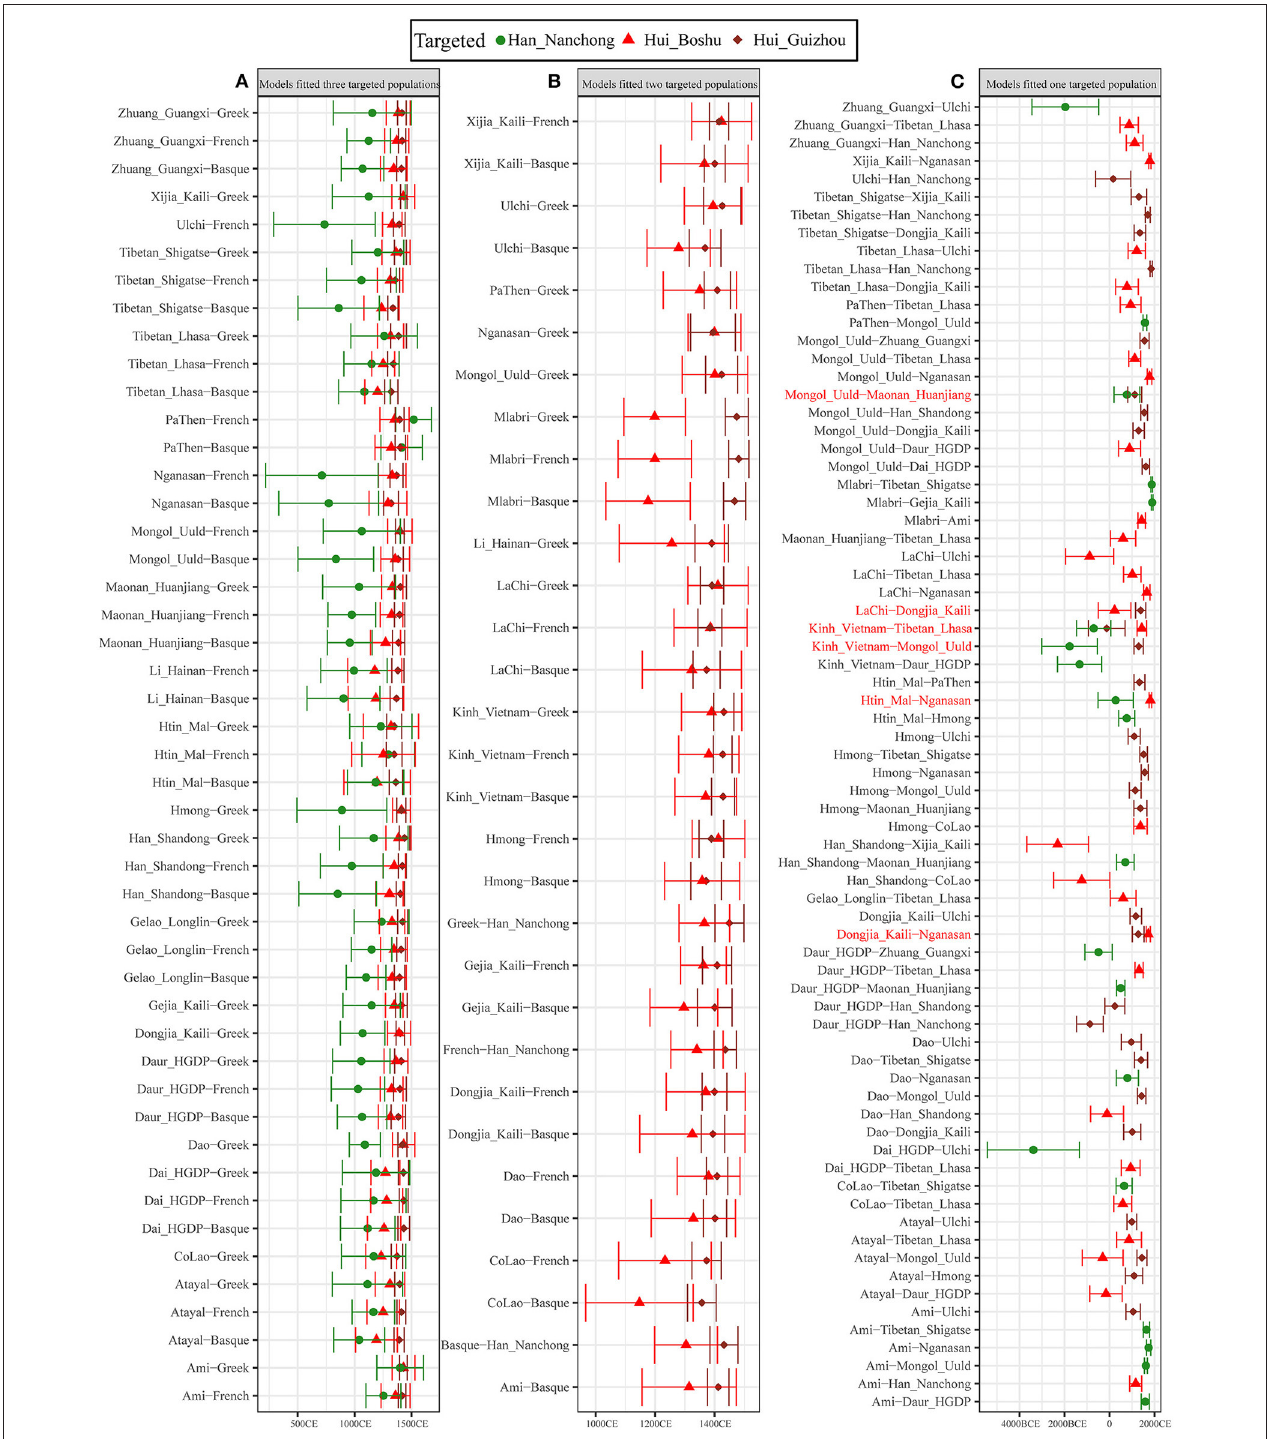
FIGURE 7 | Admixture-introduced linkage disequilibrium (ALDER)-based admixture time between different northern and southern or eastern and western ancestral sources based on the 1,240K dataset. (A) East–west ancestral source pairs fitted all three studied populations. (B) East–west ancestral source pairs fitted all two studied Hui populations but not fitted Nanchong Han. (C) East–west ancestral source pairs only fitted one studied population. One north–south ancestry source pair fitted three studied populations, and five north–south ancestry source pair fitted two studied populations also included in here; pairs were marked with the red color. We used 28 years as the one-generation length. All marked years in the bottom was calculated using the formula as Year comprehensive raw data were presented in Supplementary Table 23 .